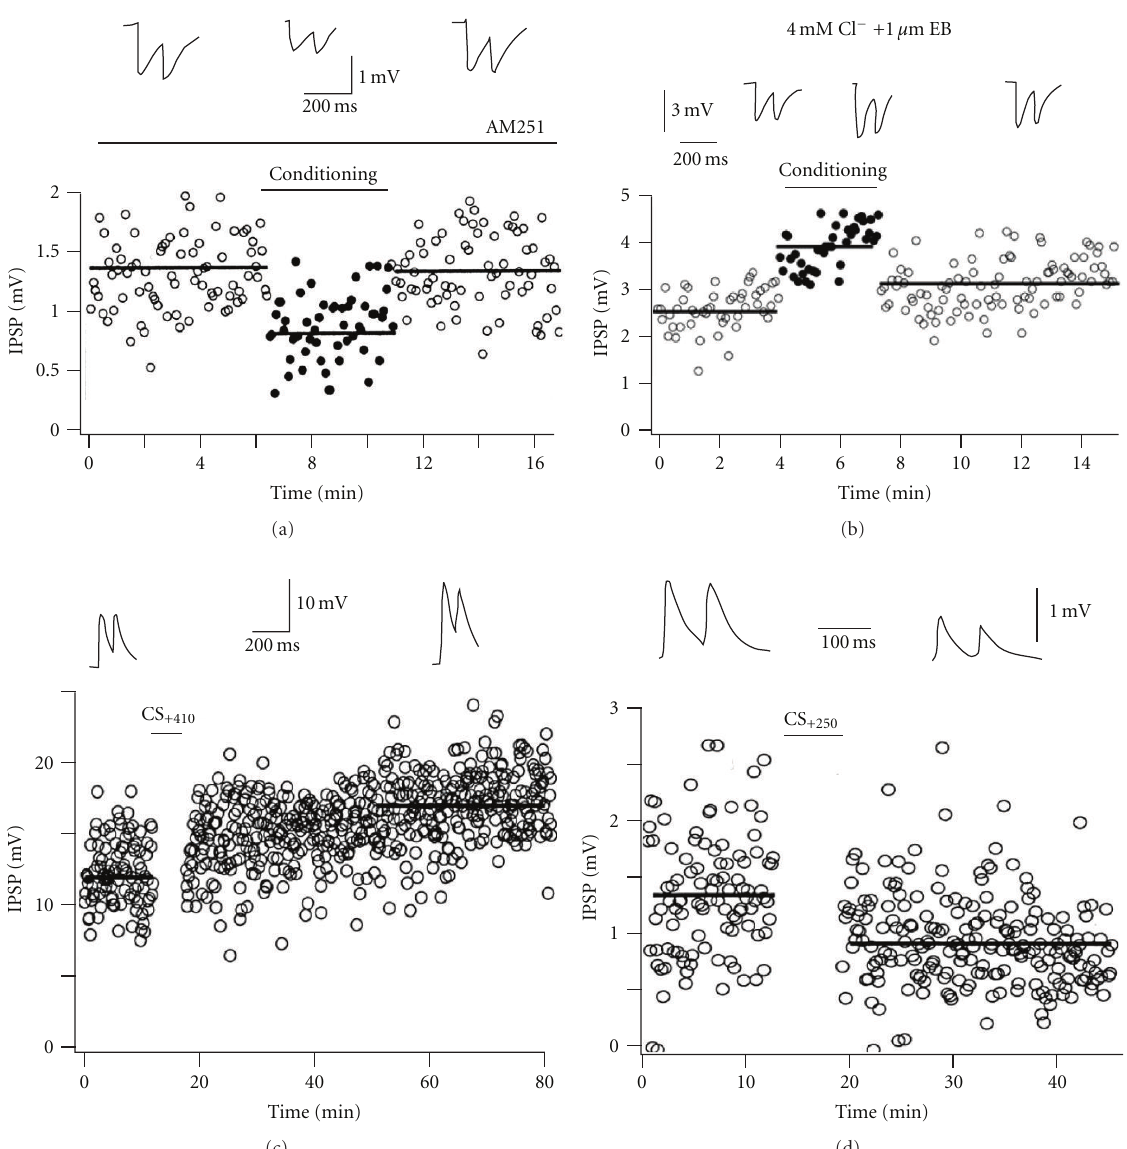
Figure 4: Endocannabinoid-independent plasticity of GABAergic synapses . (a) Brief train of action potentials (conditioning) in cortical pyramidal cells depresses unitary inhibitory postsynaptic potentials (uIPSPs) evoked by synaptically connected FS interneurons (top traces, from left to right: before, during and after conditioning). This form of short-term retrograde depression is indicated by the black dots during the conditioning paradigm (conditioned response is measured 250 ms after the conditioning stimulus), and it is not blocked by the selective CB1R antagonist AM-251, ruling out the involvement of eCB signaling. (b) Conditioning mediated depression of uIPSPs from FS interneurons (top traces, from left to right: before, during, and after conditioning) is prevented by the nonselective vesicular glutamate transporter Evans Blue (EB) suggesting a critical role for dendritically released glutamate in this form of plasticity. Modified with permission from [119]. For details see [119, 120]. (c, d) Spike timing-dependent plasticity (STDP) results in potentiation (c) and depression (d) of uIPSPs (top) elicited by FS interneurons onto cortical pyramidal cells. Long-term potentiation (LTP) of uIPSP amplitudes (top traces) is obtained when presynaptic FS cell fires 410 ms after the beginning of a brief train of action potentials (10 action potentials at 50Hz) in the postsynaptic pyramidal cell (c). Conversely, long-term depression (LTD) of uIPSPs is observed when the presynaptic FS cell fired 250